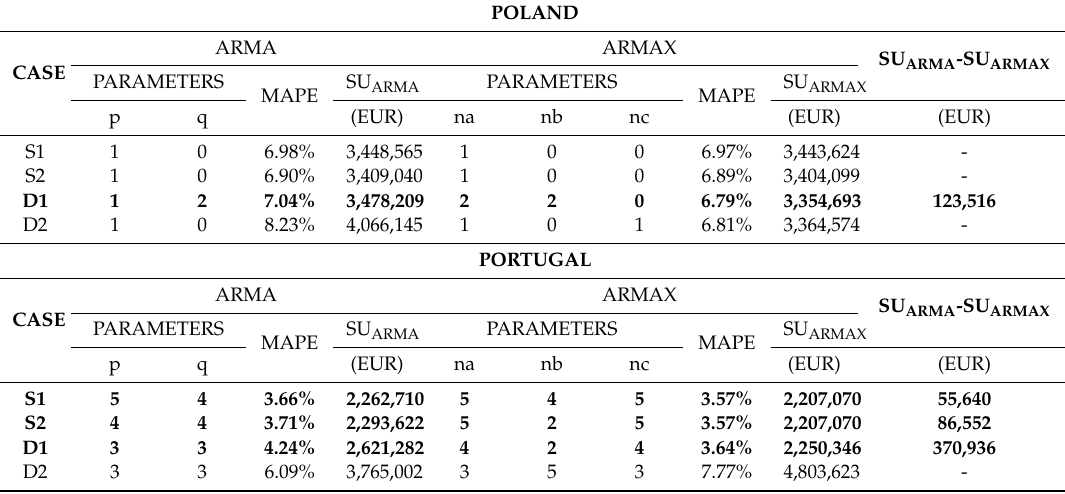
Table 5. Comparison of the auto-regressive moving average (ARMA) and ARMA with exogenous inputs (ARMAX) spot prices forecasting